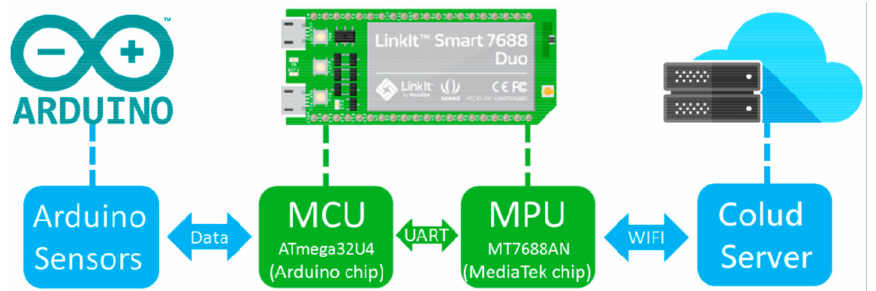
Figure 5. LinkIt Smart 7688 Duo Support Program